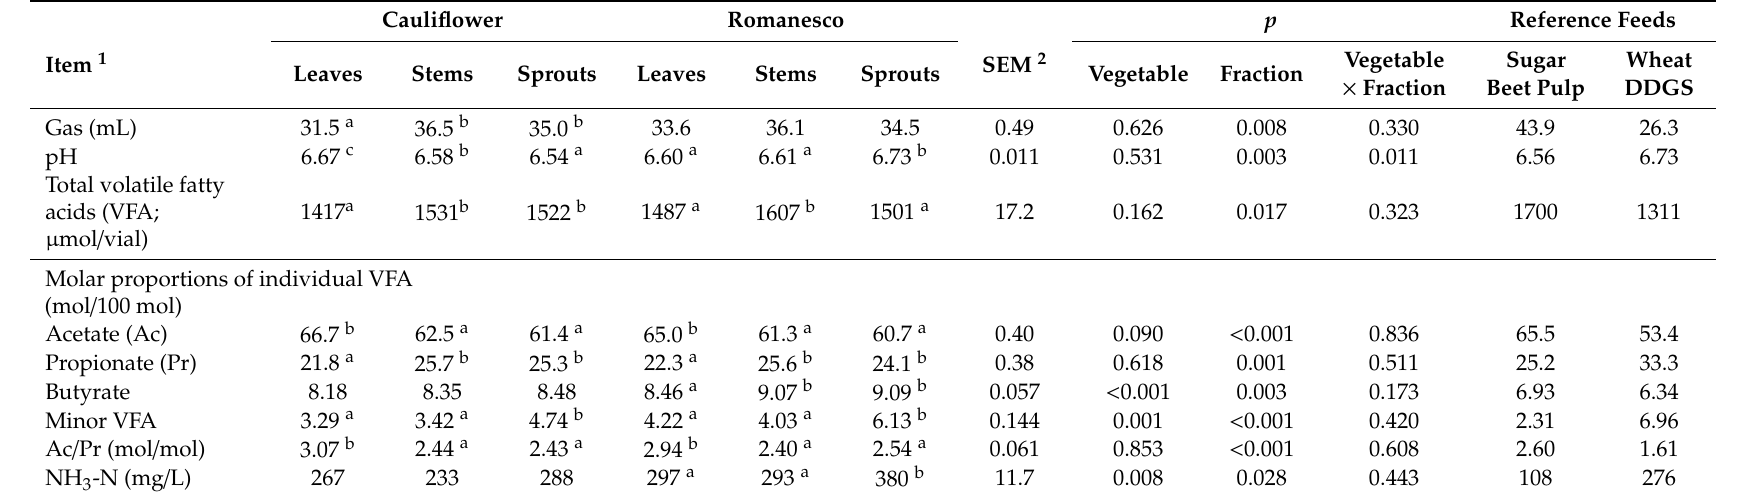
Table 3. Fermentation parameters of di ff erent fractions of cauliflower and Romanesco and two reference feeds (sugar beet pulp and wheat DDGS) samples (200